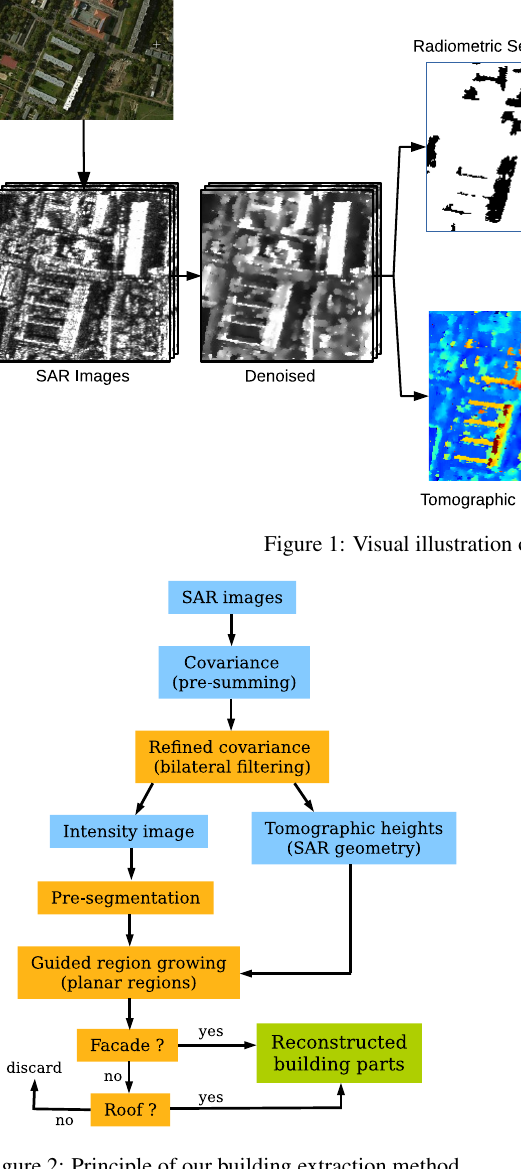
Figure 2: Principle of our building extraction method.